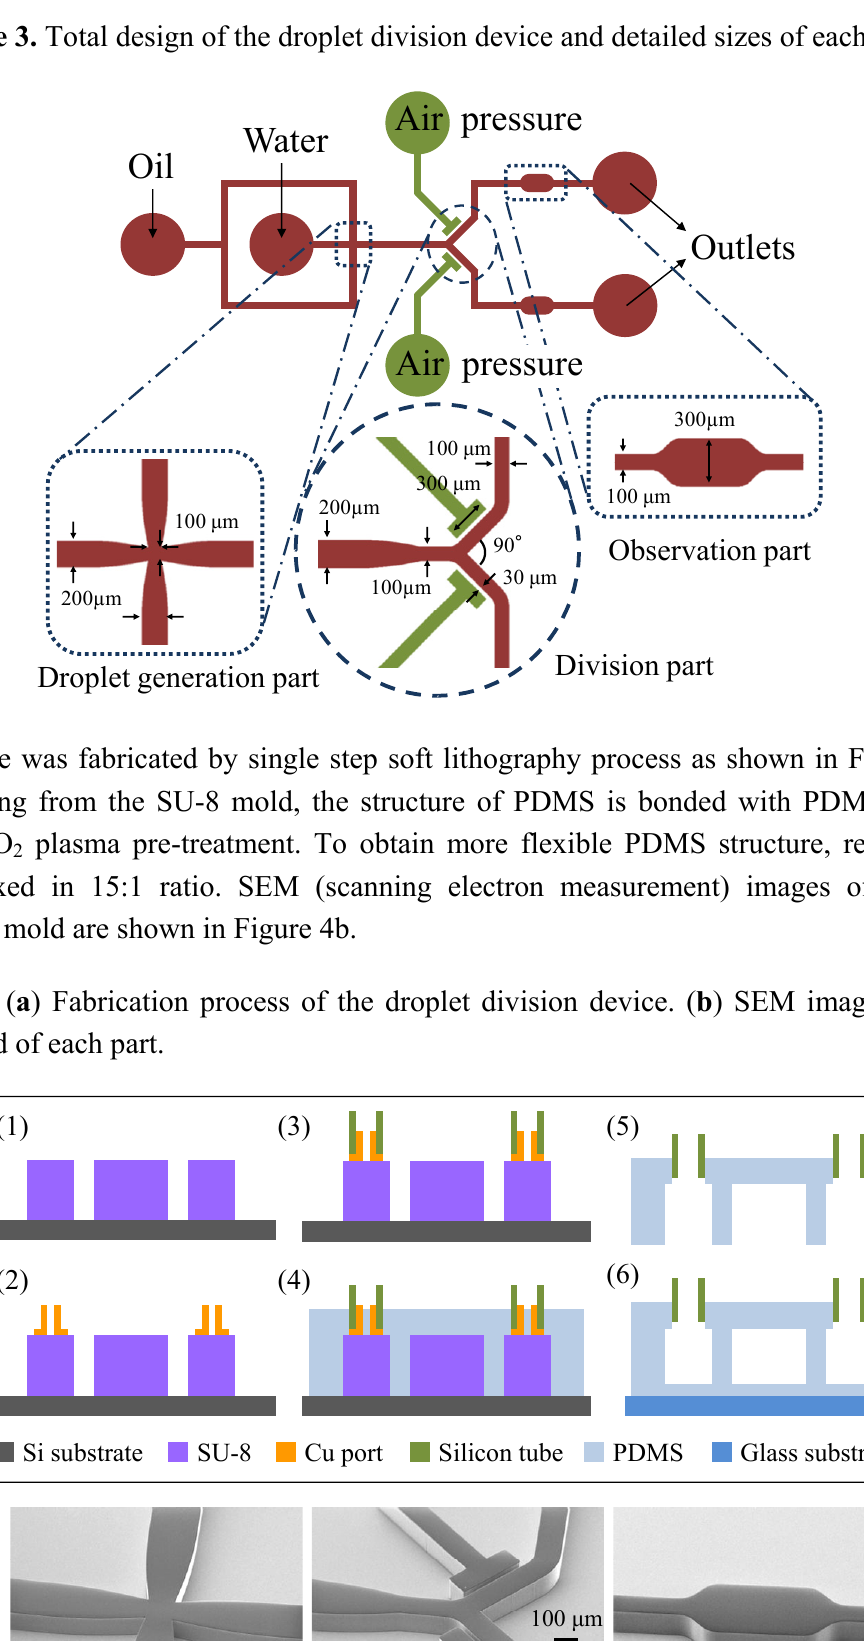
Figure 3. Total design of the droplet division device and detailed sizes of each part.